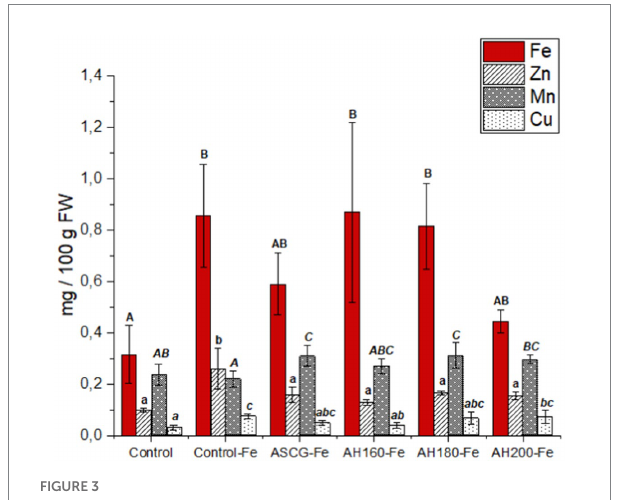
FIGURE 3 Fe and other micronutrients contents in the edible part of lettuce in the different treatments. The bars represent the standard deviations of the means ( N = 4). Different capital letters indicate statistically significant differences ( p < 0.05) in Fe content, lower-case letters in Zn content, capital italic letters in Mn and lower-case italic letters in Cu. FW: fresh weight.